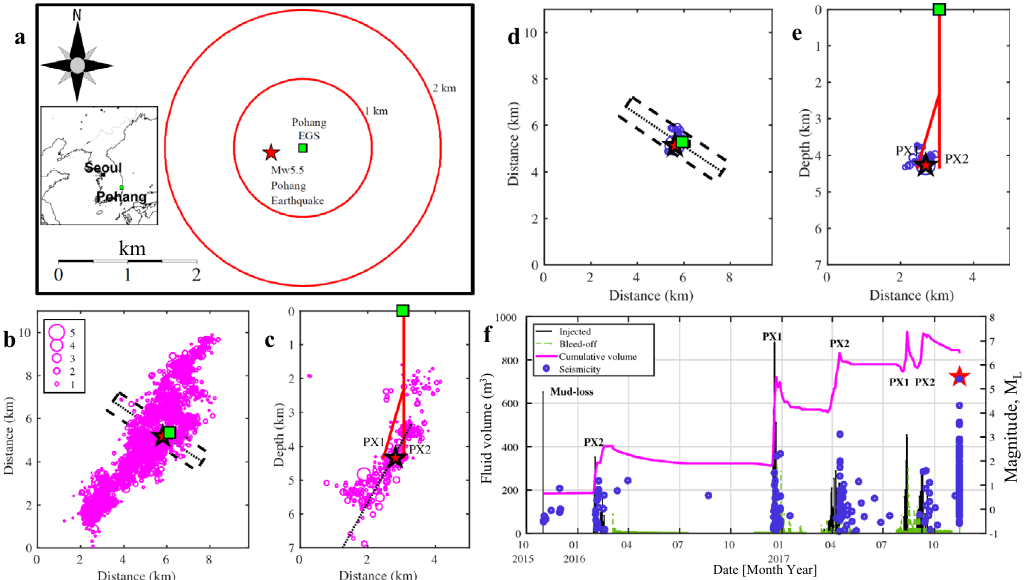
Fig. 2 Seismicity and fl uid injection at the Pohang Geothermal Site 11, 18, 20 . The Mw5.5 Pohang earthquake is shown by the red stars. The Pohang EGS is shown by the green squares. a Pohang EGS and its location in Korea (the inset map). The red circles represent 1-km distances from the site. b , c Hypocenters of the 2017 Mw5.5 earthquake and its aftershocks 65 (magenta circles with the event-magnitude scale (inset on b )). The aftershocks from the rectangle domain (black dashed contour on b and d ) are shown projected on the vertical section c parallel to the dotted line in the centre of the rectangle domain. c Boreholes PX1 and PX2, the aftershocks and the Pohang Earthquake fault 65 (black dotted line). d , e Hypocenters of the Mw ≥ 0.9 fl uid-injection- induced earthquakes (blue circles with the event-magnitude scale (inset on b )) at the Pohang EGS 18, 20 . f Timeline of fl uid injection (black line), bleed- off 11, 18 (dashed green line), cumulative injected volume (magenta line) and the fl uid-injection-induced earthquakes 18, 20 (blue circles) at the Pohang